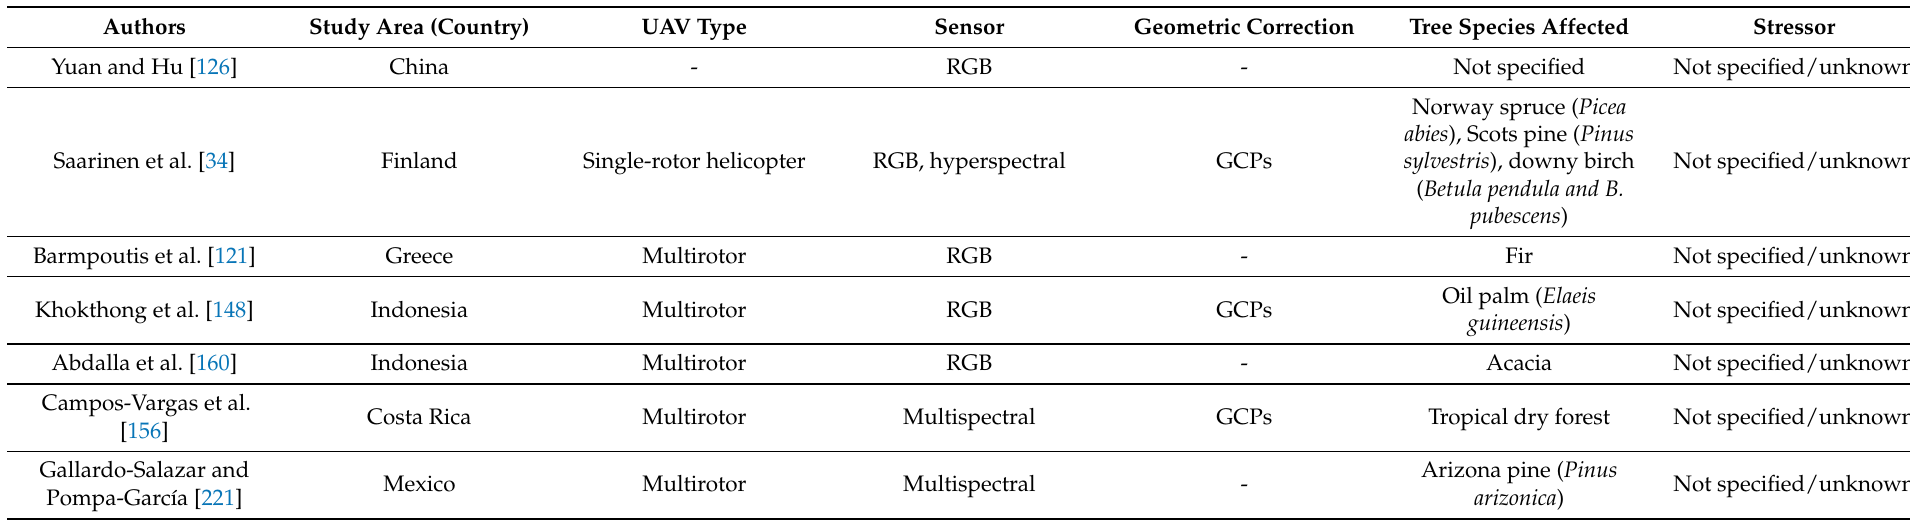
Table A5. Stressor not defined/unknown: reviewed articles in which no stressor was